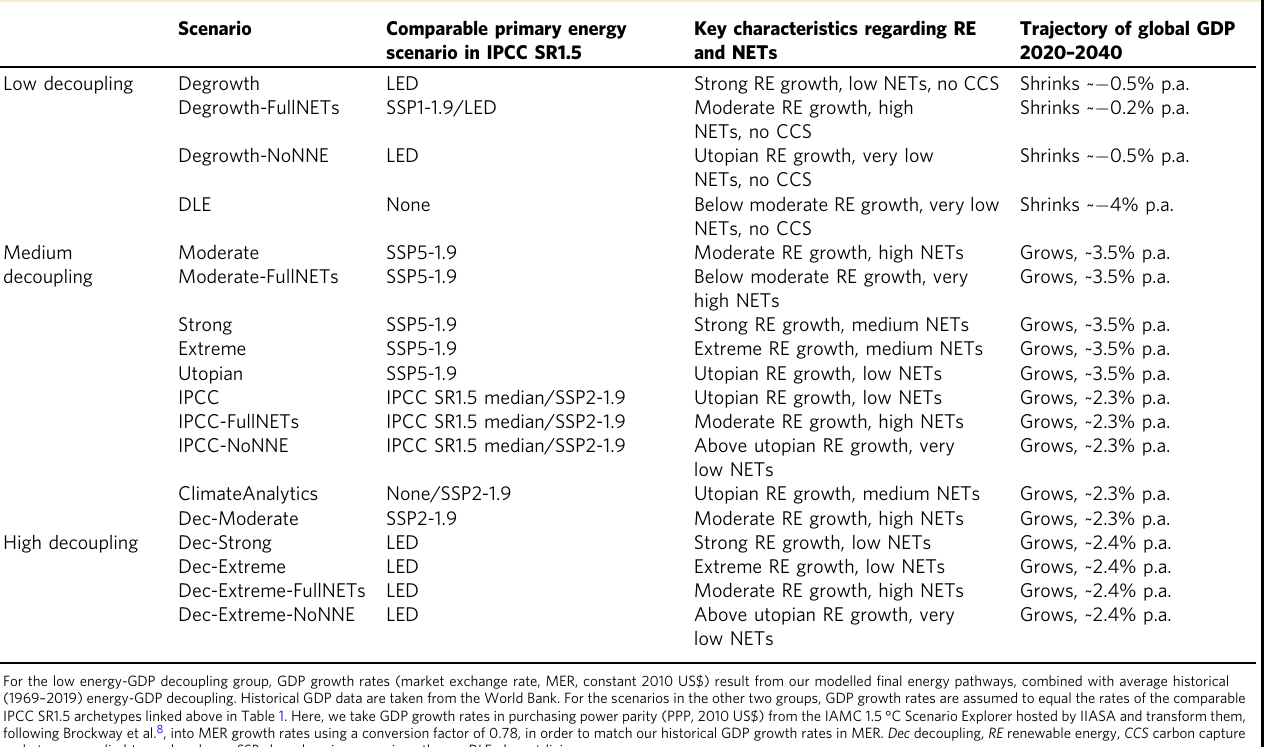
Table 1 Description of our scenarios and comparison with the IPCC SR1.5.